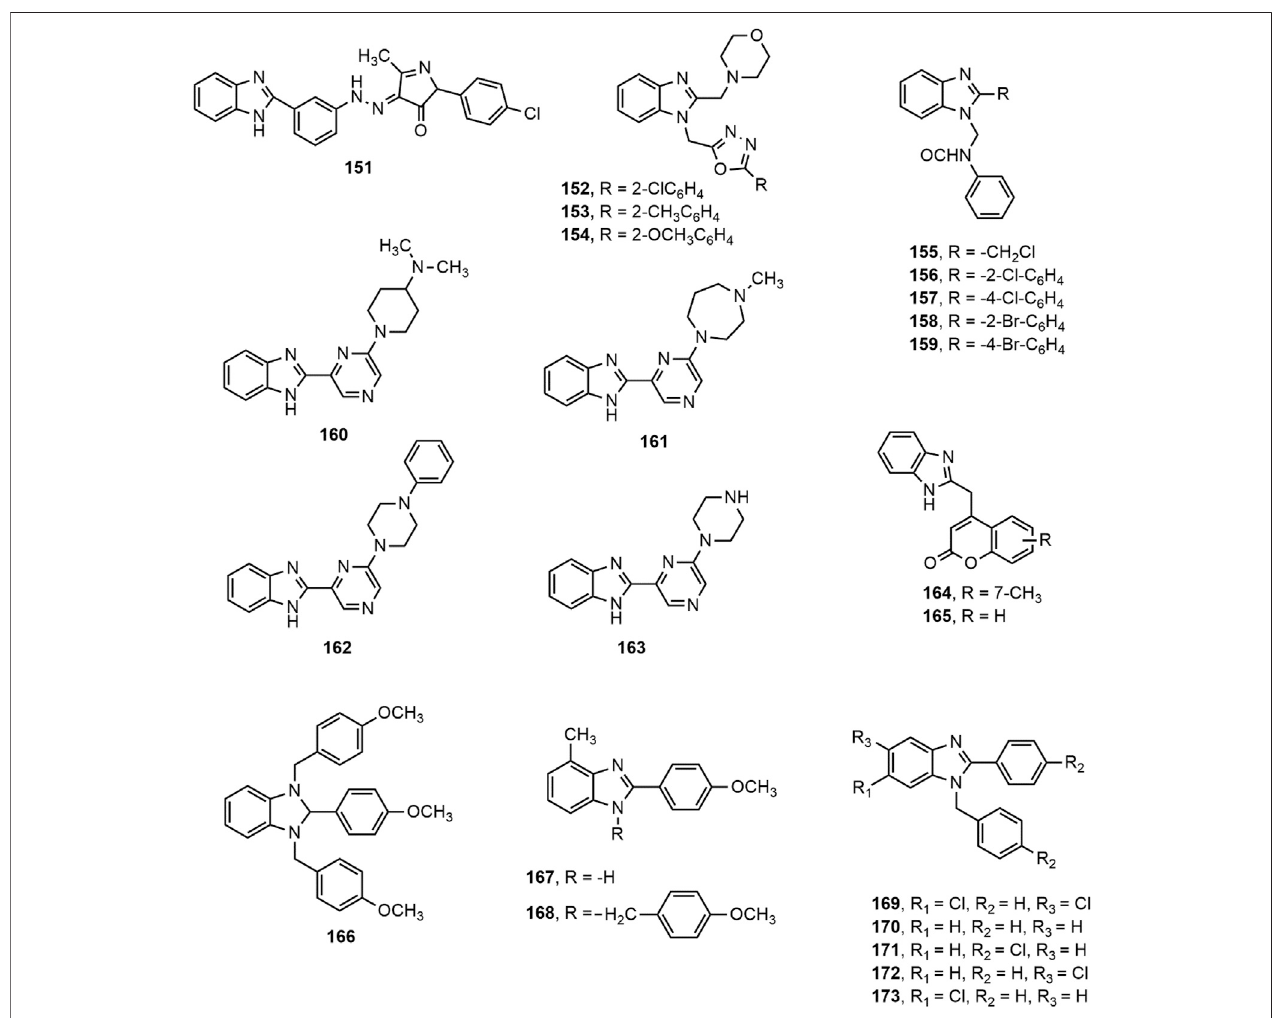
FIGURE 5 | Benzimidazole derivatives with anti-in fl ammatory and analgesic activity.